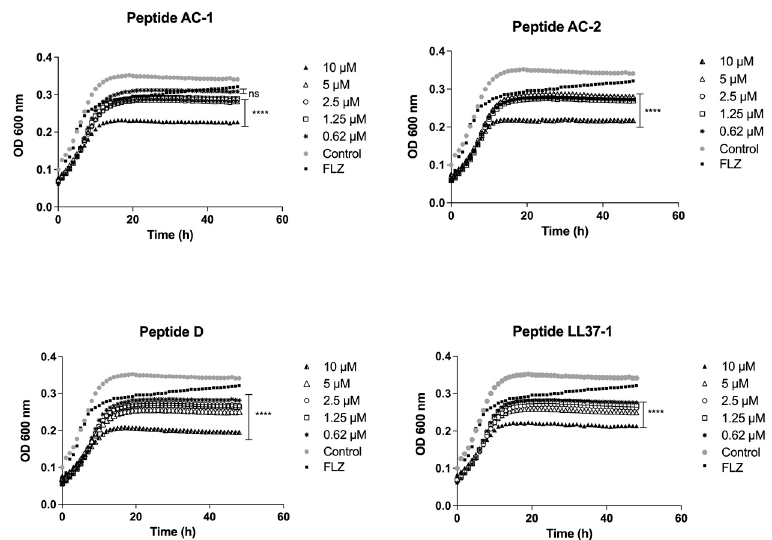
Figure 4. Growth curves of C. krusei ATCC 6558. Four LL-37-derived peptides (AC-1, AC-2, D, and LL37-1) were tested at different concentrations (10, 5, 2.5, 1.25, and 0.62 µM). C. krusei ATCC 6558 cells without exposure to antimicrobial peptides were used as a control. Fluconazole (64 µg/mL) was used as antifungal control. Data represent three independent experiments. Statistical significance **** p < 0.0001 when compared to control.